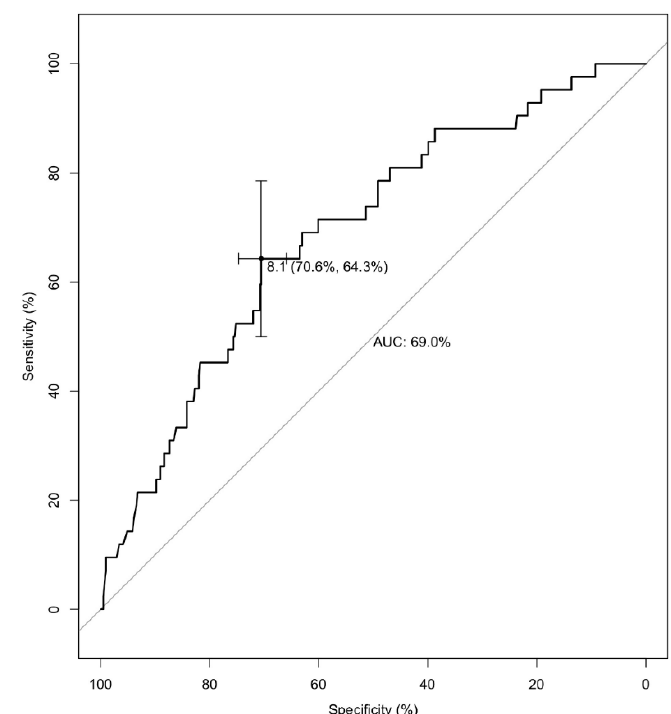
Figure 1. Receiver operating characteristic (ROC) analysis. Time (in months) from CNI-based to belatacept-based therapy regarding the occurrence of opportunistic infections. ROC analysis: area under the curve (AUC) value = 0.69, specificity 70.6%, sensibility 64.3% for a time to conversion at 8 months after kidney transplantation.